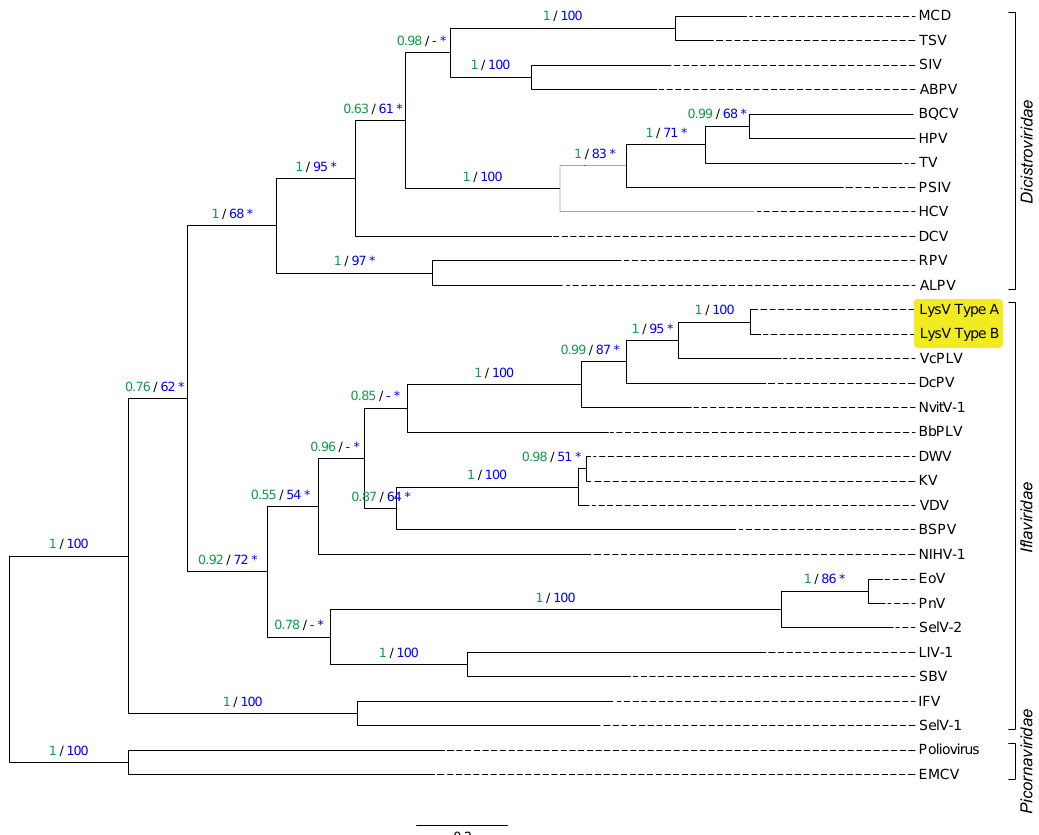
Figure 7. Phylogenetic tree showing that both haplotypes of the detected virus (LysV highlighted in yellow) belong to the Iflaviridae family (order Picornavirales ). The tree was constructed from amino acid alignments of the RdRP gene and is shown with Bayesian posterior probabilities (green) and maximum likelihood bootstrap support values (blue). Values of at least 0.5% and 50%, respectively, are indicated. Asterisks indicate non-identical bootstrap support values between maximum likelihood runs. If this is the case, the single highest value is shown (replicate values did not differ by more than 6%). The scale bar is proportional to the number of amino acid substitutions per site.